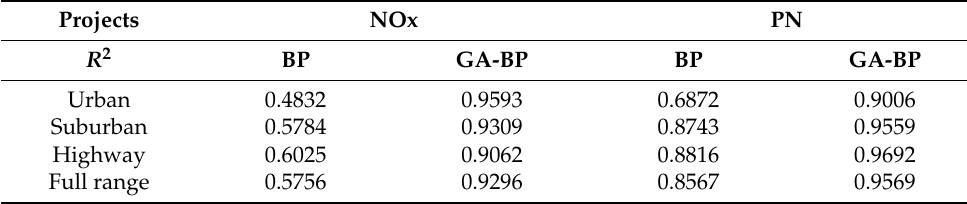
Table 5. Comparison of R 2 of pollutant prediction results under BP and GA-BP NN.